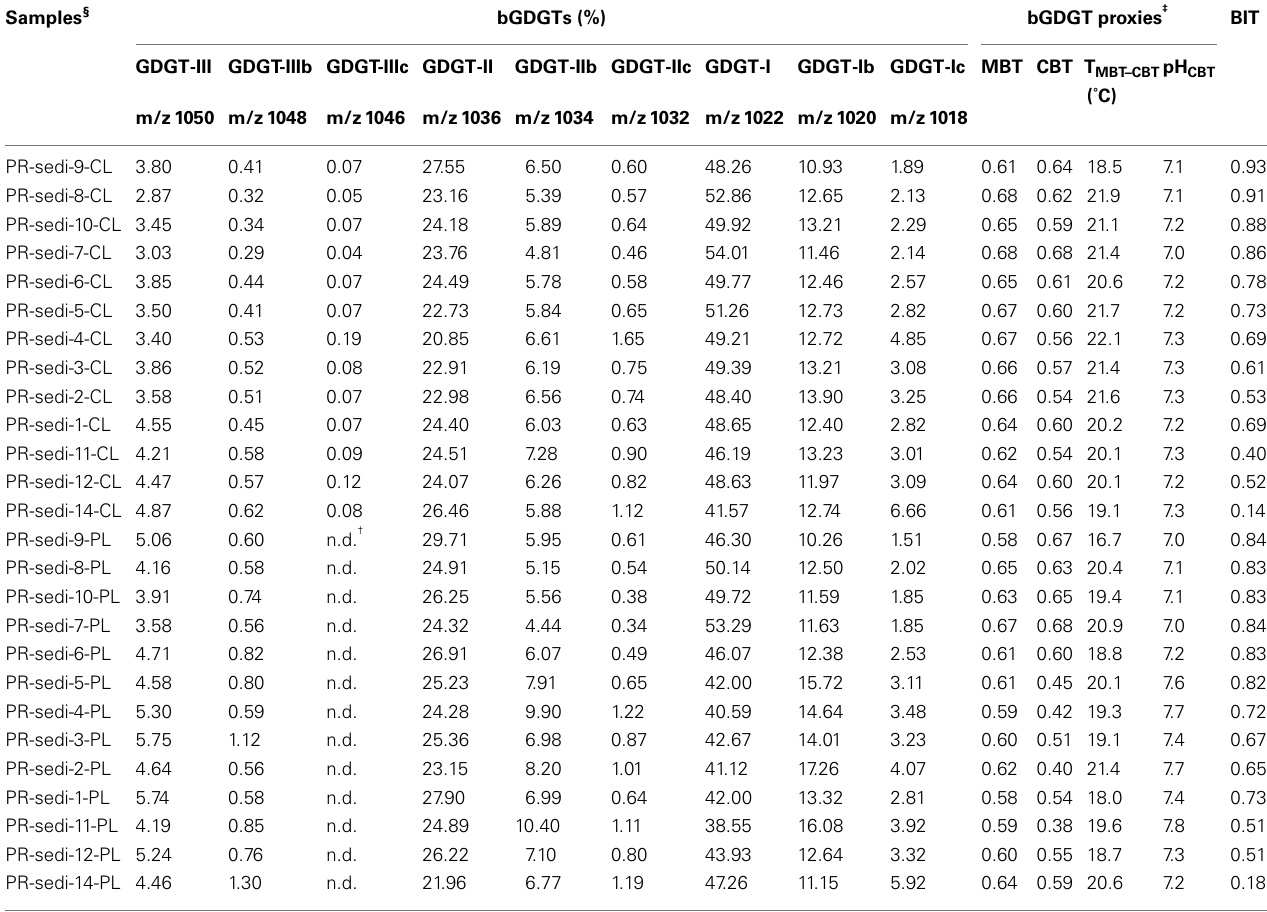
TableA2 | Bligh and Dyer method-derived bGDGTs and proxies for sediment samples. Samples